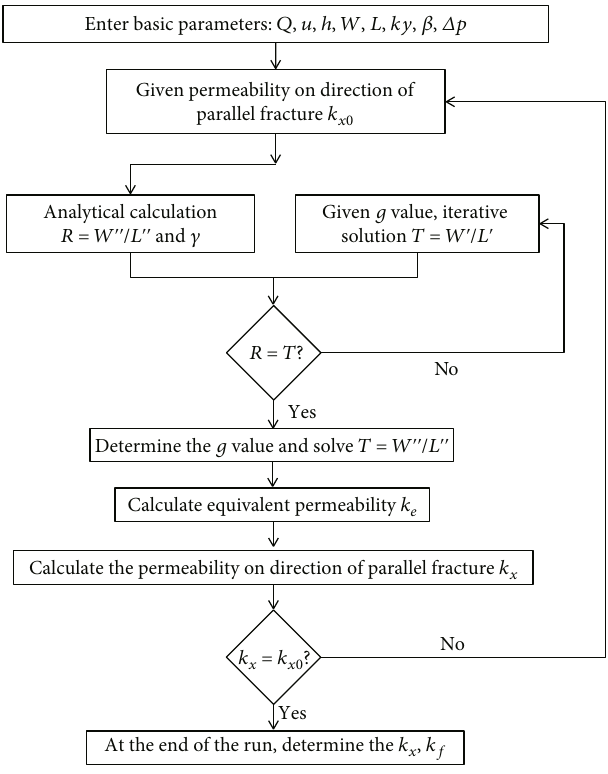
Figure 10: Fracture permeability semianalytical model solver calculation fl ow